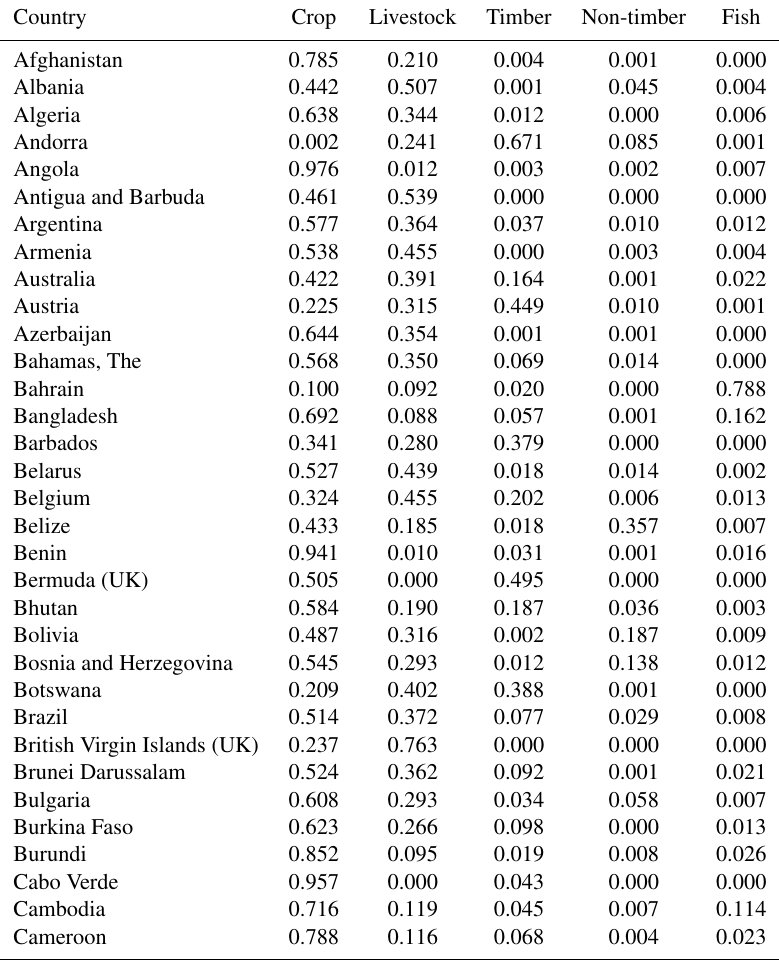
Table B8. Share of priors in territory. Country